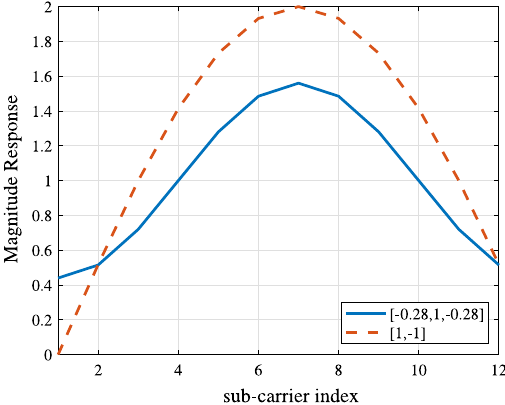
Fig. 5 Magnitude response of various spectral shaping